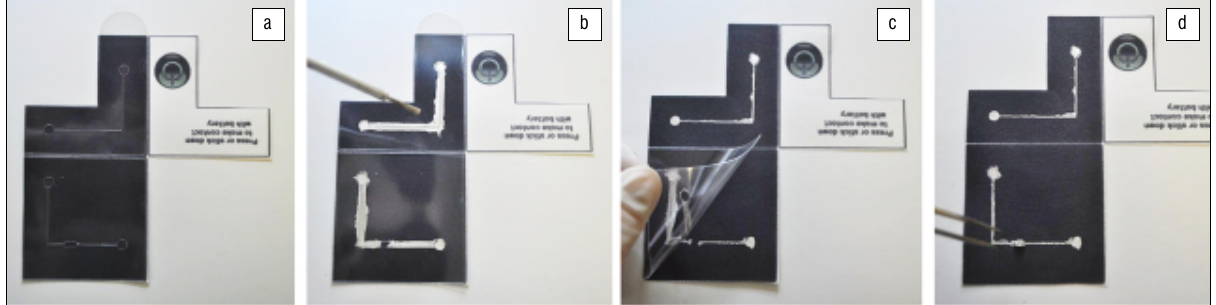
Figure 9: Manual manufacture of a simple electronic device integrated on wax-printed paper: (a) adhesive layer stencils are stuck onto the wax printed areas; (b) application of the conductive nanosilver paint within the adhesive stencil areas; (c) removal of the stencil; (d) mounting of electronic components for the complete